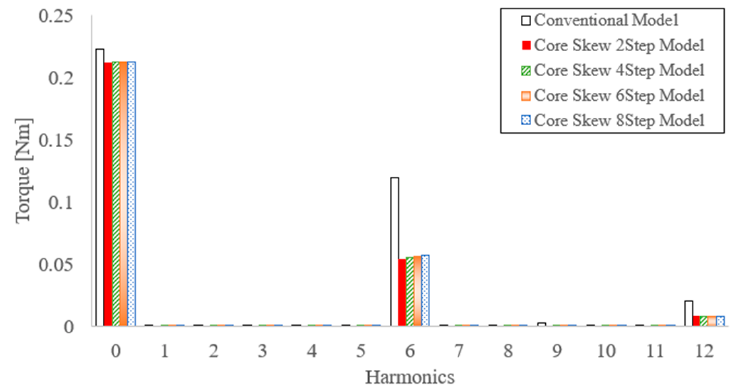
Figure 18. 15,660 rpm torque waveform comparison according to the number of steps.